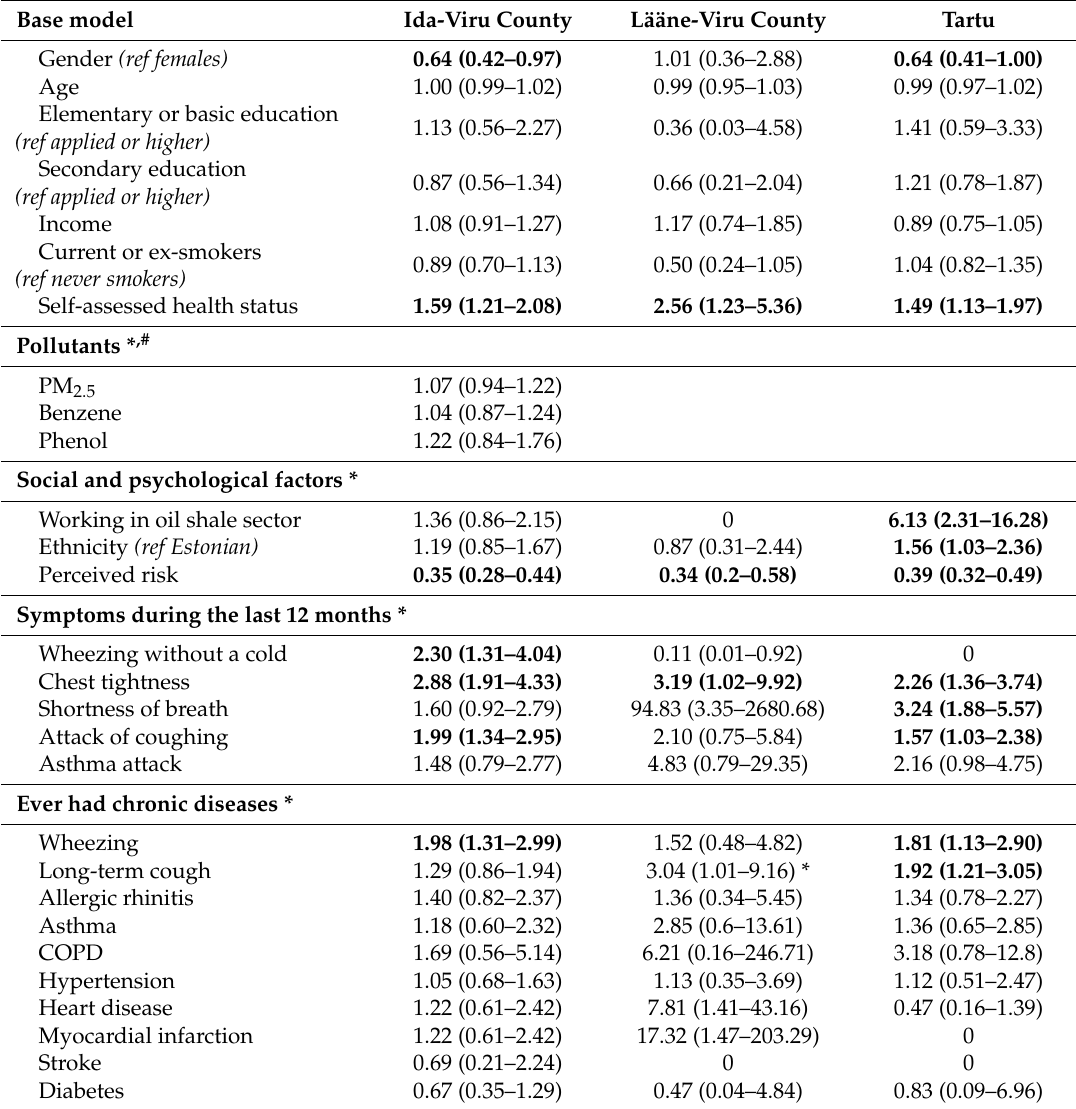
Table 4. Association between specific factors, air pollutants and the prevalence of annoyance in the three investigated counties, odds ratios (95%